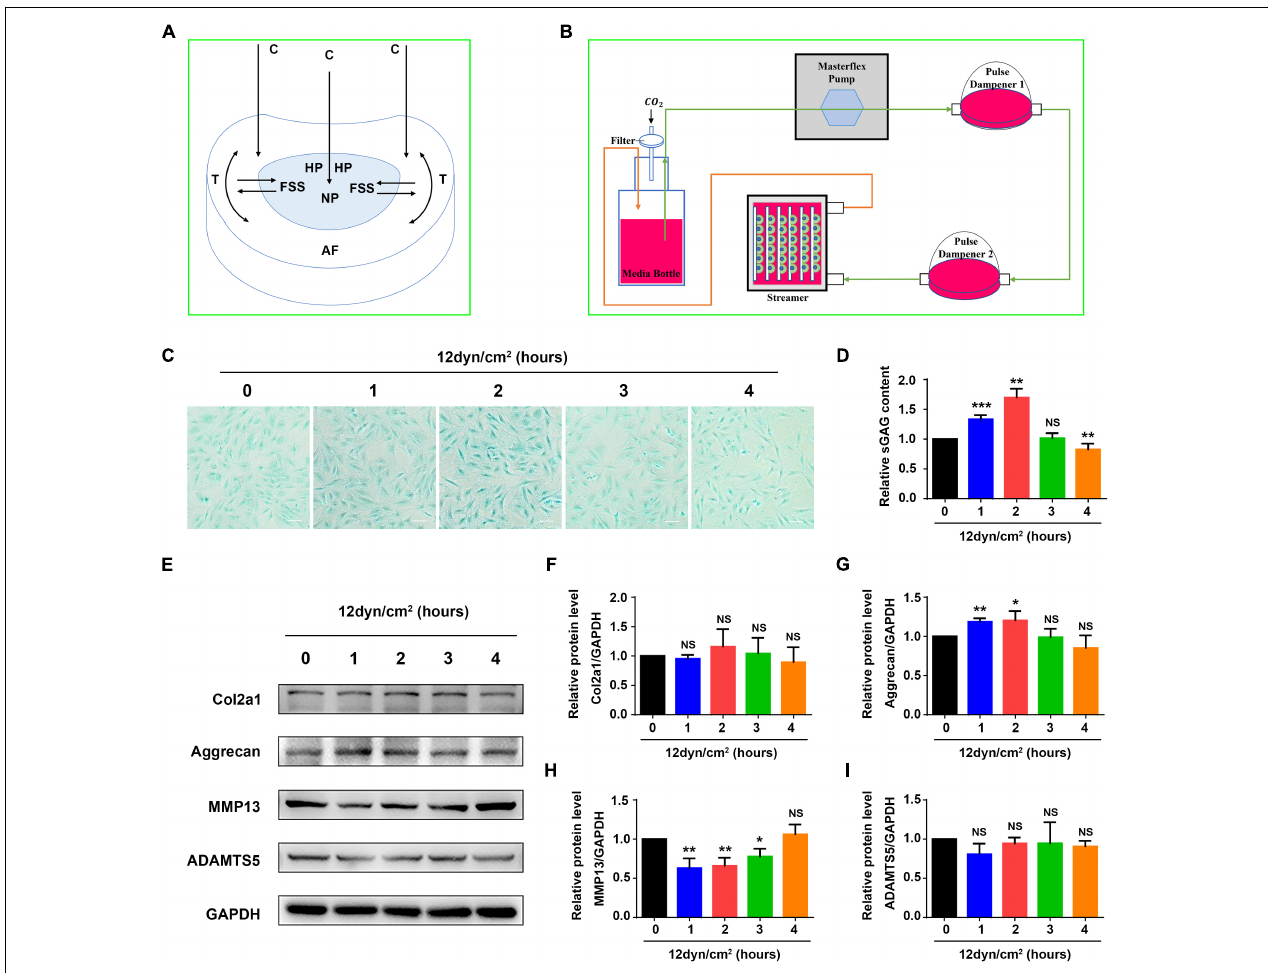
FIGURE 1 | Fluid shear stress regulates expression of ECM proteins and sGAG content in nucleus pulposus cells. (A) The formation of fluid shear stress (FSS) in nucleus pulposus cells (NP). Compressive stress (C), hydrostatic pressure (HP), and tensile stress (T) are indicated. (B) Schematic diagram of the Flexcell Streamer System. (C) Alcian blue staining. NP cells were treated with 12 dyne/cm 2 FSS for the indicated times. Bar, 100 µ m. (D) sGAG content. NP cells were treated as in panel (B) , followed by the Blyscan Sulfated Glycosaminoglycan Assay. (E–I) Western blotting. NP cells were treated as in panel (C) , followed by Western